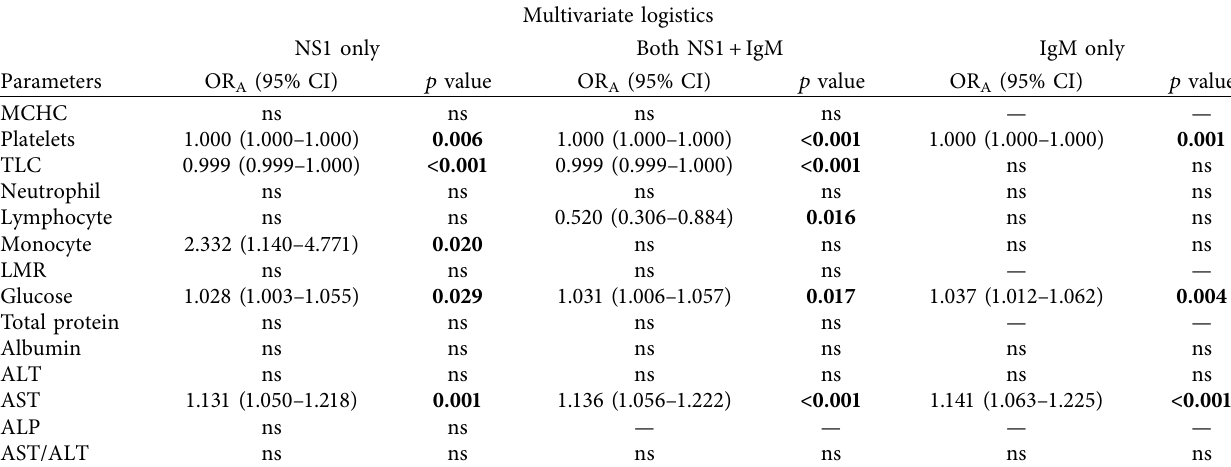
Table 6: Multinomial multivariate logistic regression analysis for laboratory parameters in NS1, both NS1 +IgM, and IgM positive dengue patients with the dengue negative group as